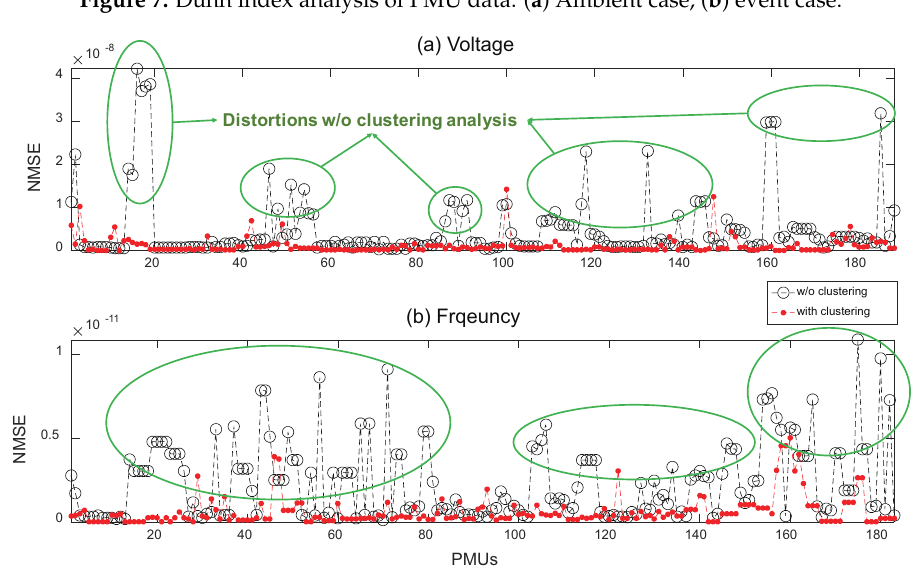
Figure 8. NMSE results of every PMU. ( a ) Voltage, ( b )